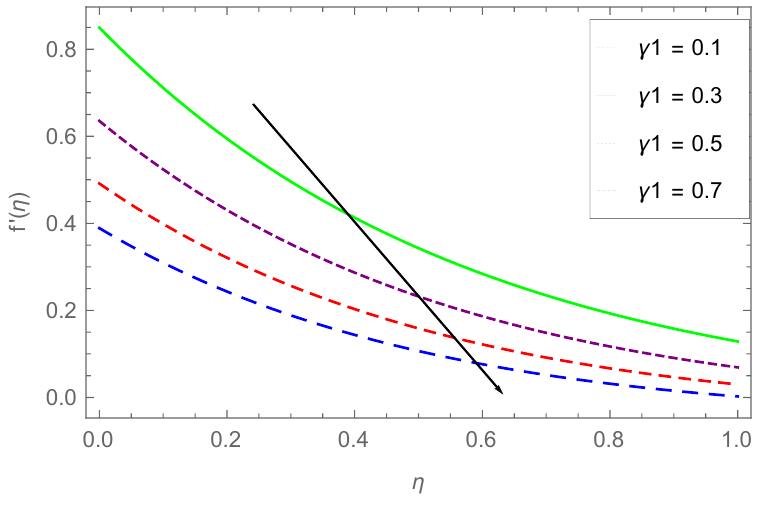
Figure 4. Dependence of f (cid:48) ( η ) over γ